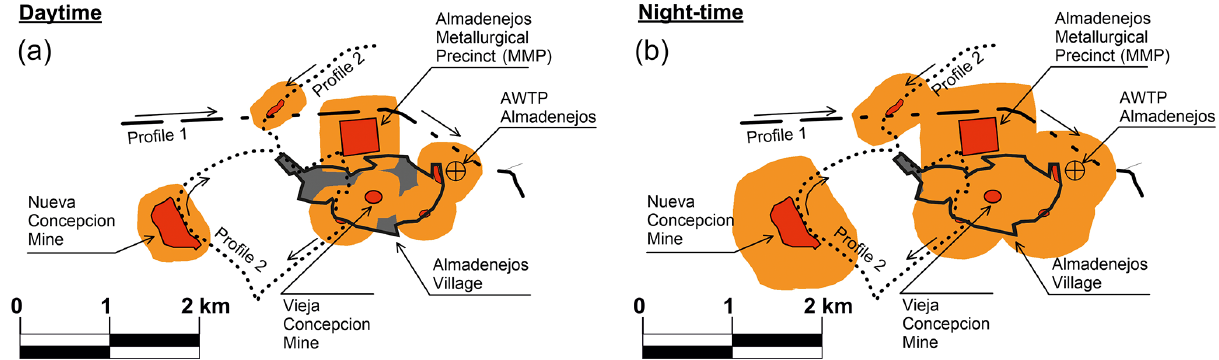
Figure 9. Extent of areas with Hg inhalation risk in the worst scenarios (orange) in relation to the different source areas (red) during daytime (a) and night-time (b)